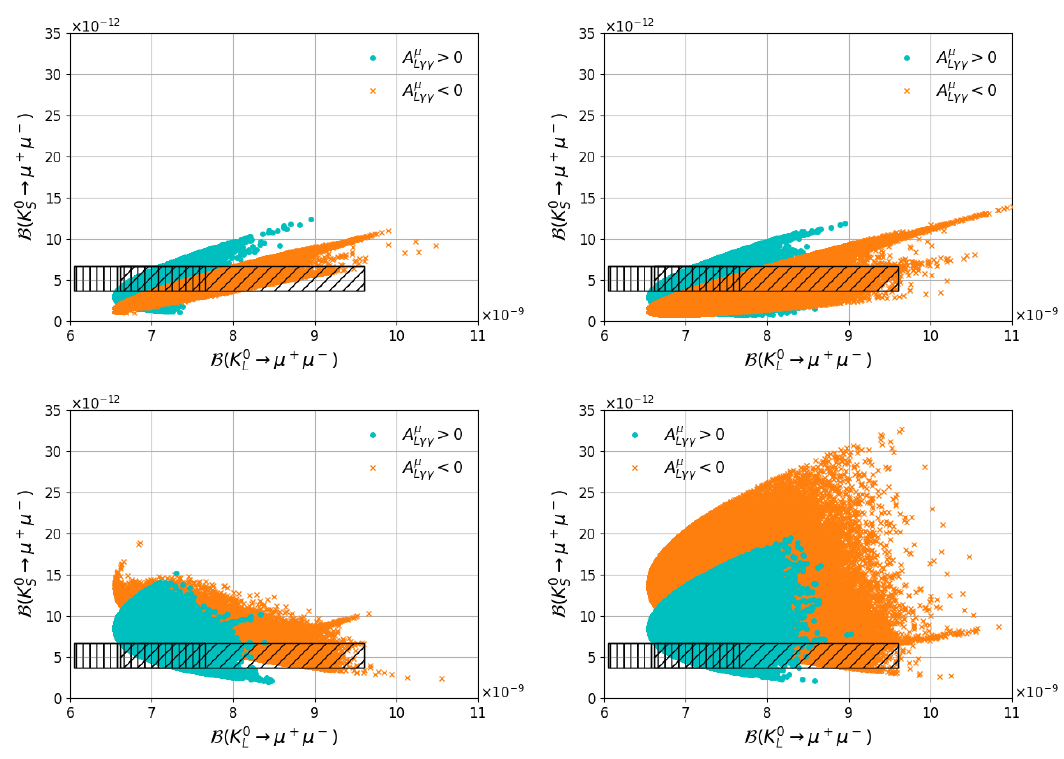
! (cid:22) + (cid:22) (cid:0) ) L